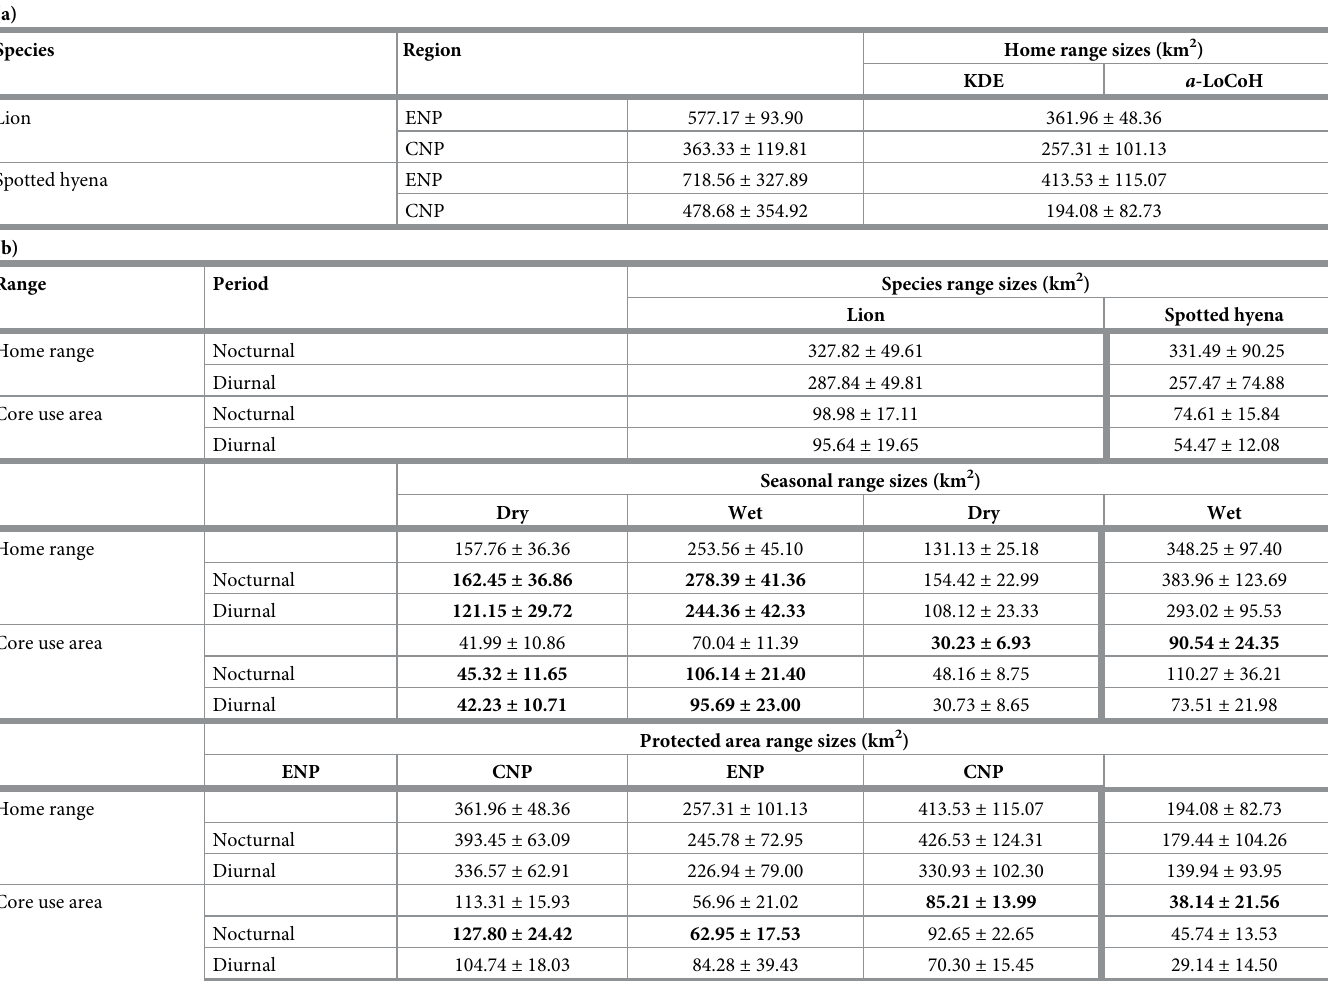
Table 3. Lion and spotted hyena range sizes (km 2 ).